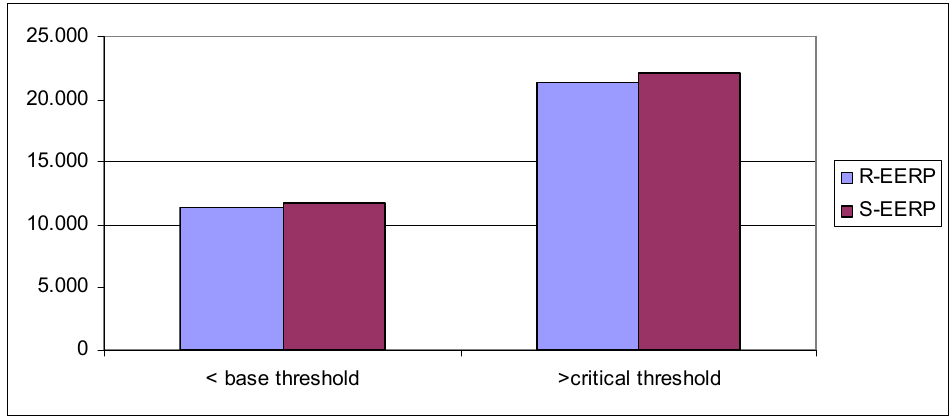
Figure 4. The ignored values which were below the base the base threshold and the values above the critical threshold which were immediately sent to sink.